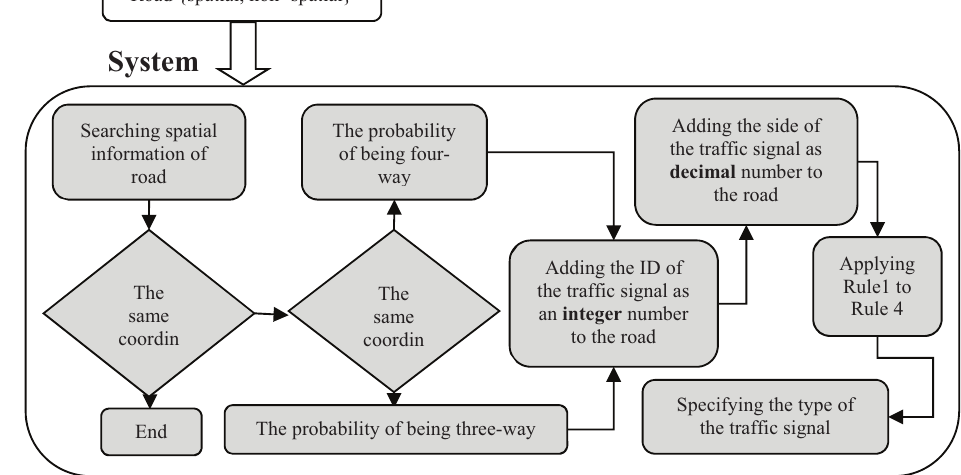
Figure 1. The structure of proposed